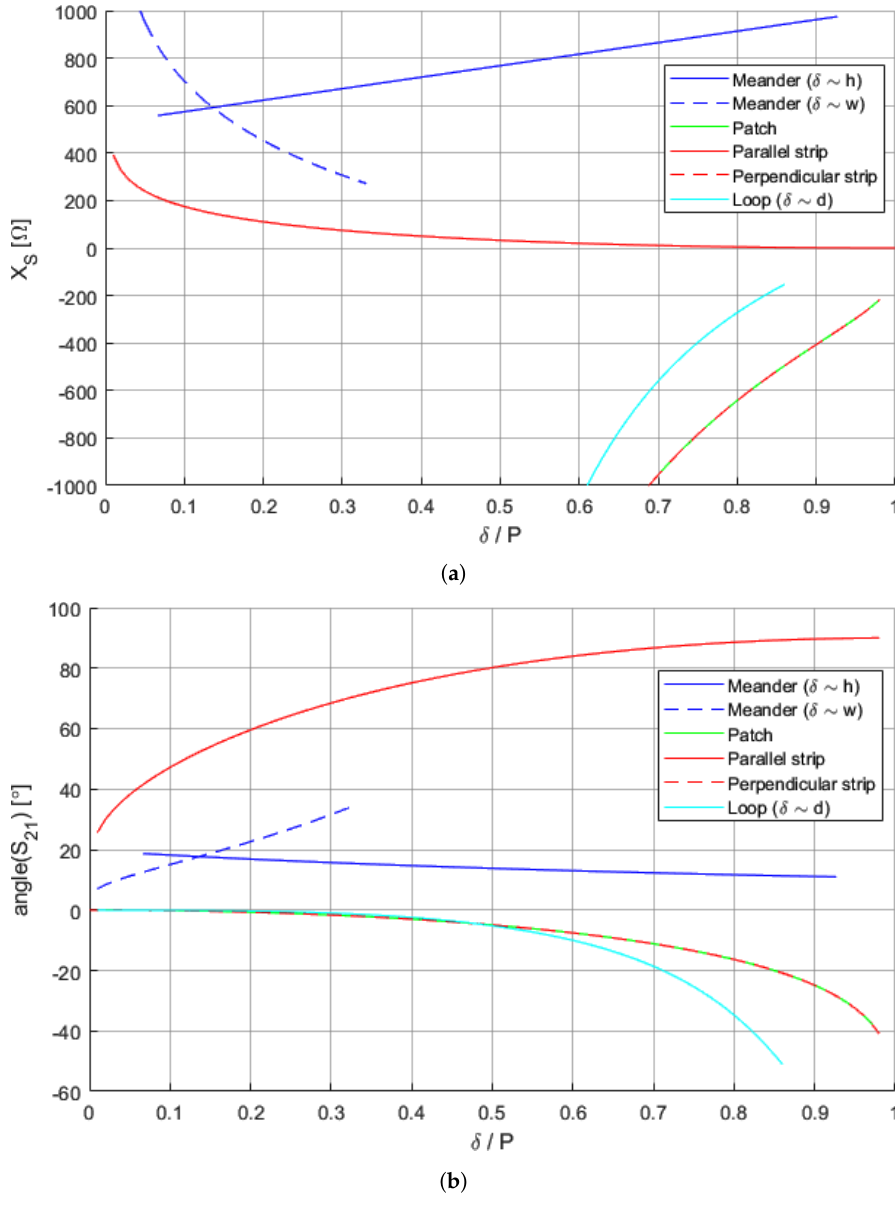
Figure 11. Comparison of electrical parameters for different unit cell types for a y -polarized normally-incident wave. P = 7.854mm, f = 10GHz. ( a ) Surface sheet reactances; ( b ) phase